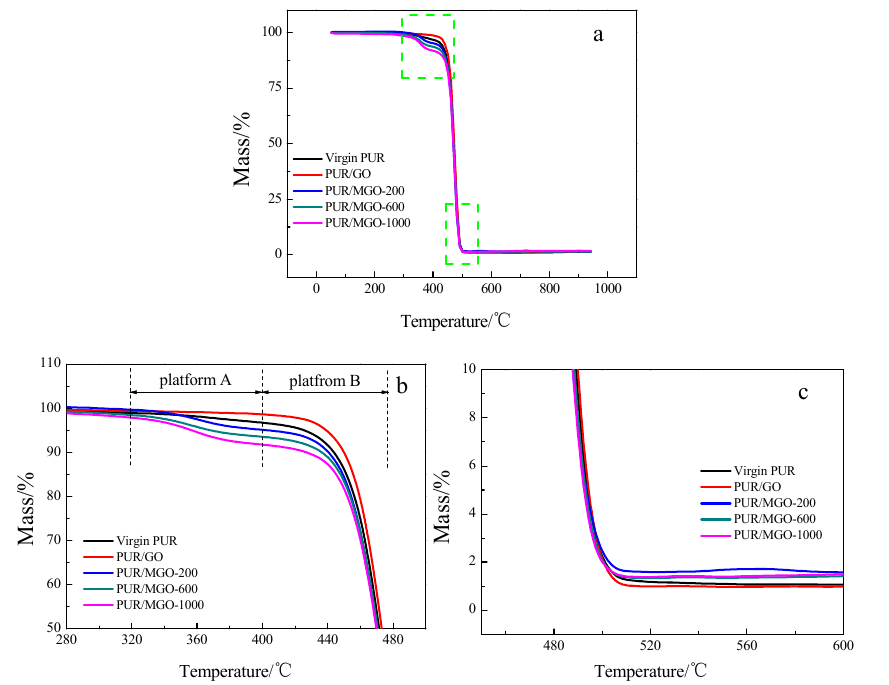
Figure 3. Thermogravimetric analysis of PUR, PUR/GO and PUR/MGO. ( a ) full image; ( b ) partial enlargement of ( a ); ( c ) partial enlargement of ( a ). Table 3. Key data of thermogravimetric analysis of PUR, PUR/GO and PUR/MGO.